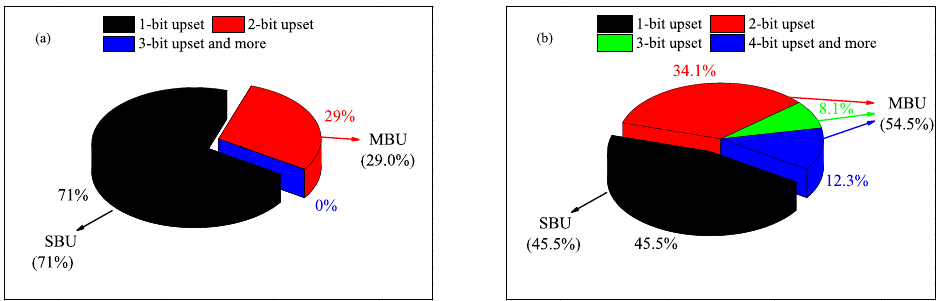
Figure 8. Proportion of SBU and MBU in: ( a ) DICE hardened structure; and ( b ) 6-T